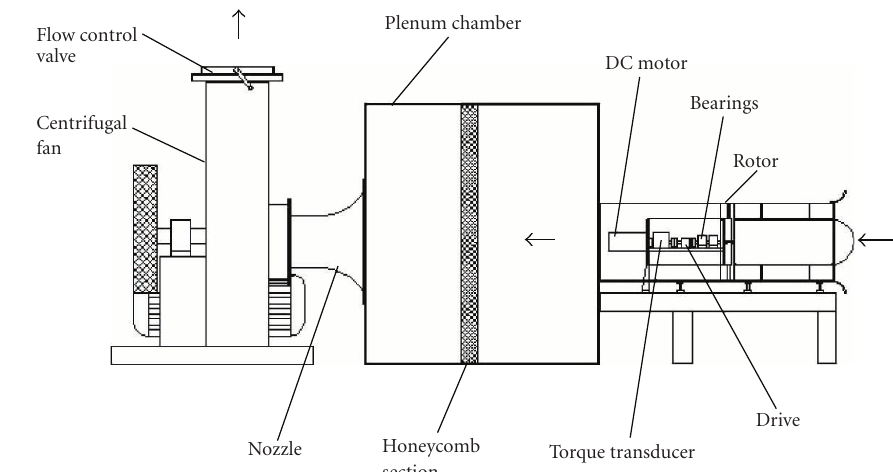
Figure 2: Schematic diagram of test rig.